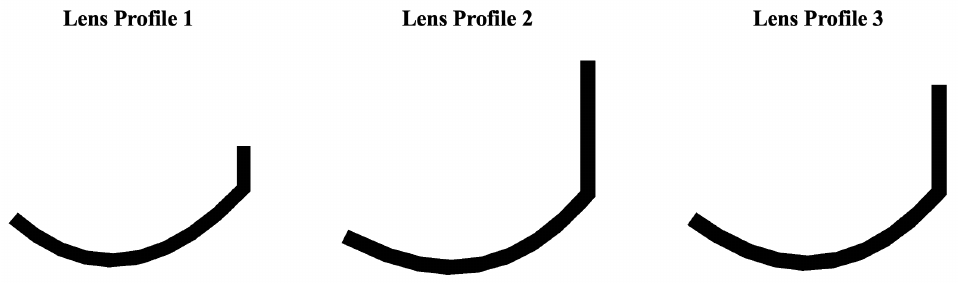
Figure 6. Three different wind lens profiles (Profile 1, Profile 2, and Profile 3) used in the present